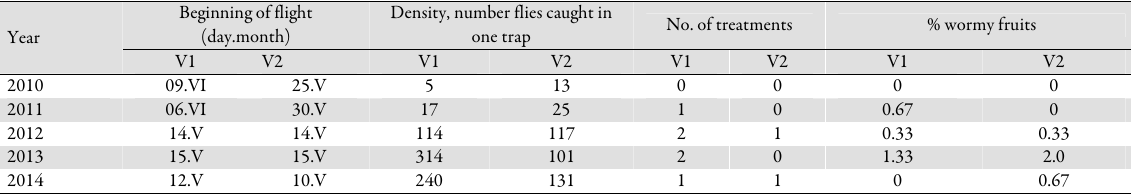
No. of treatments % wormy